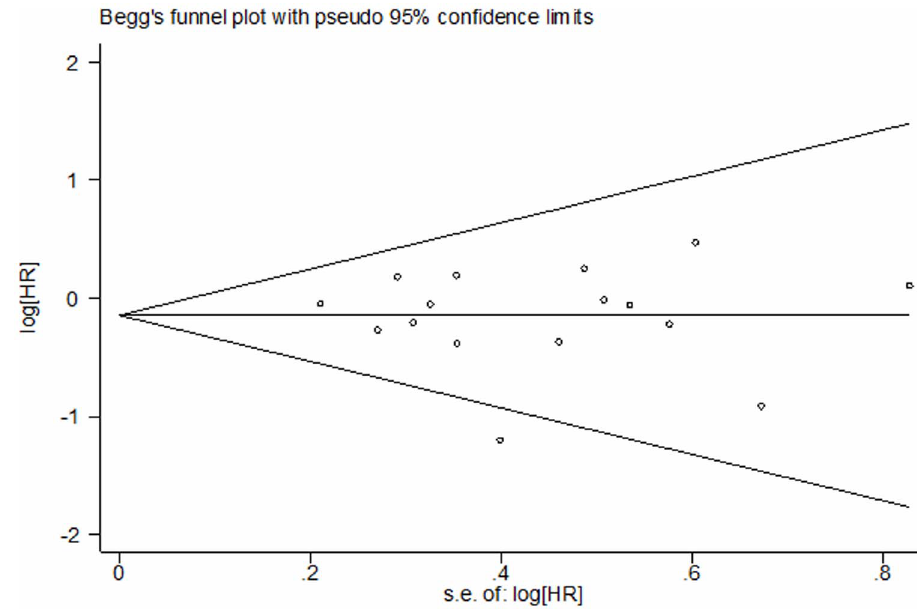
Figure 9. Funnel plot for publication bias test OS. The two oblique lines indicate the pseudo 95% CI.